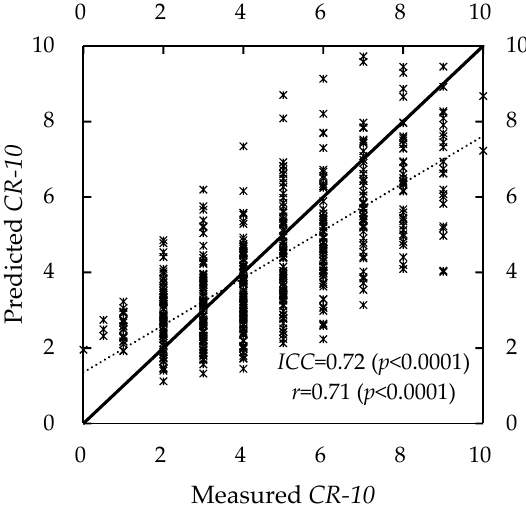
Figure 8. Comparison of predicted and measured CR-10 using Equation (18).